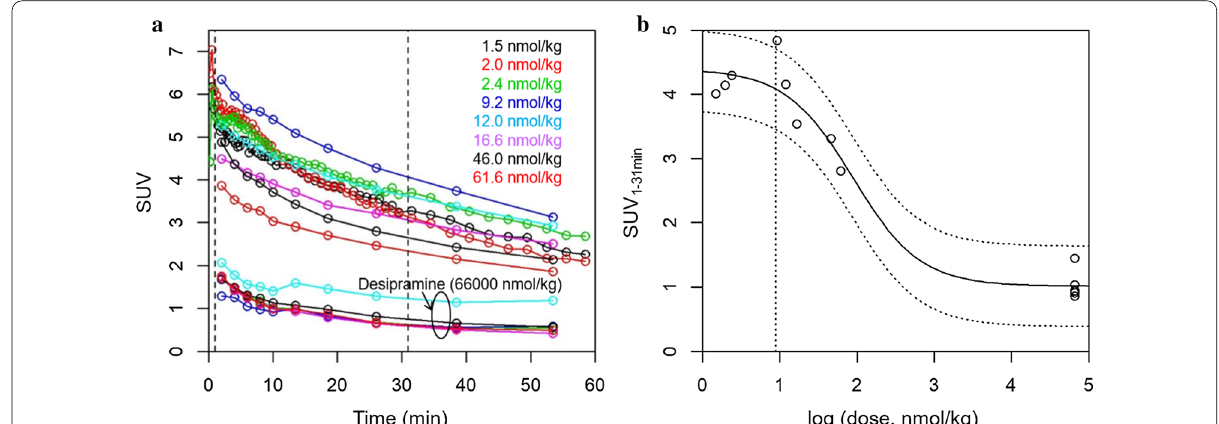
Fig. 4 Dose dependency of [ 11 C]mHED uptake in the mouse myocardium. a TACs (SUV) of myocardium at the indicated dose of combined [ 11 C] mHED and metaraminol. Desipramine, 66 ′ 000 nmol/kg, corresponds to 20 mg/kg desipramine HCl. Broken vertical lines indicate 1 and 31 min, respectively, the time window for SUV 1–31 min averaging. TACs with shorter time intervals are from the scans for kinetic modelling. b SUV 1–31 min was plotted against the dose on logarithmic scale (base 10). Solid line, fit according to Eq. 3 with fit D 50 intervals. Broken vertical line indicates 1/10 D